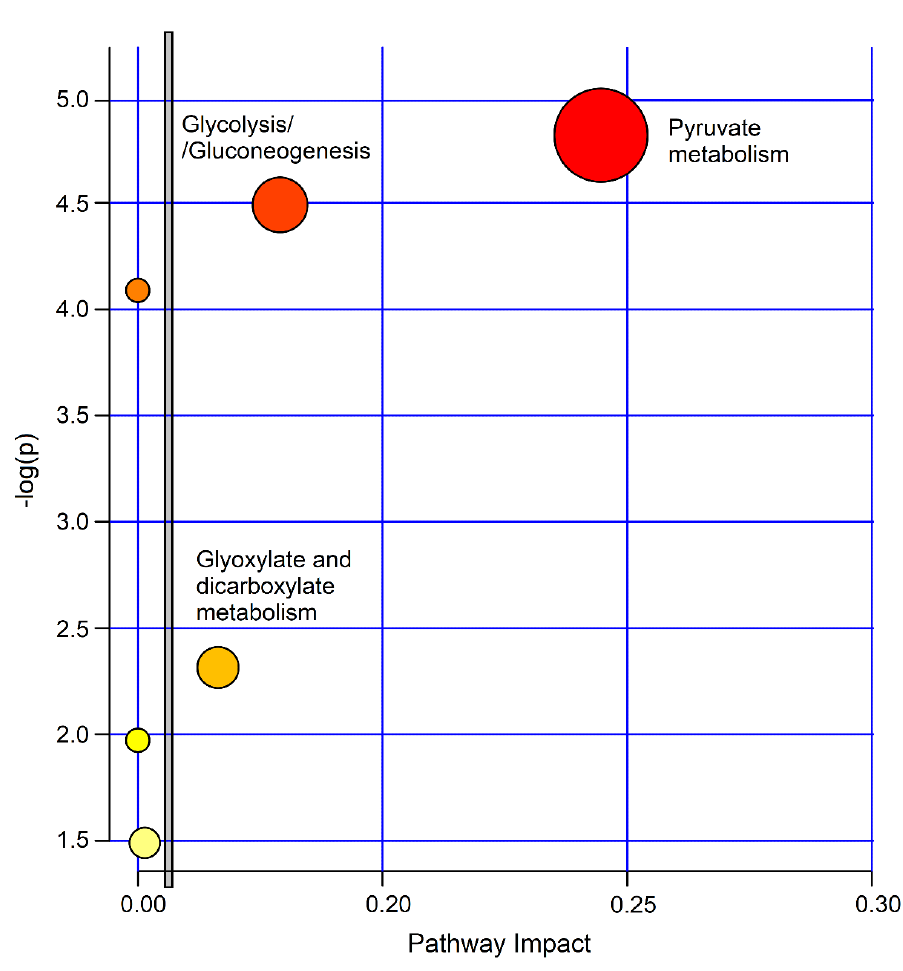
Figure 10. MetaboAnalyst-4.0 impact percentage of metabolic pathways as obtained from metabolites responsible for nCF / nPCD PCD class separation. Circles represent dysregulated metabolic pathways potentially involved in class separation. The most probable divergent metabolisms are labeled (pyruvate, p = 1.51 × 10 − 5 ; impact, 0.24; glycolysis / gluconeogenesis ( p = 3.24 × 10 − 5 ; impact, 0.18; glyoxylate and dicarboxylate metabolism p = 0.00490; impact, 0.16). The vertical bar separates the 3 metabolisms with a higher impact located on the right side.